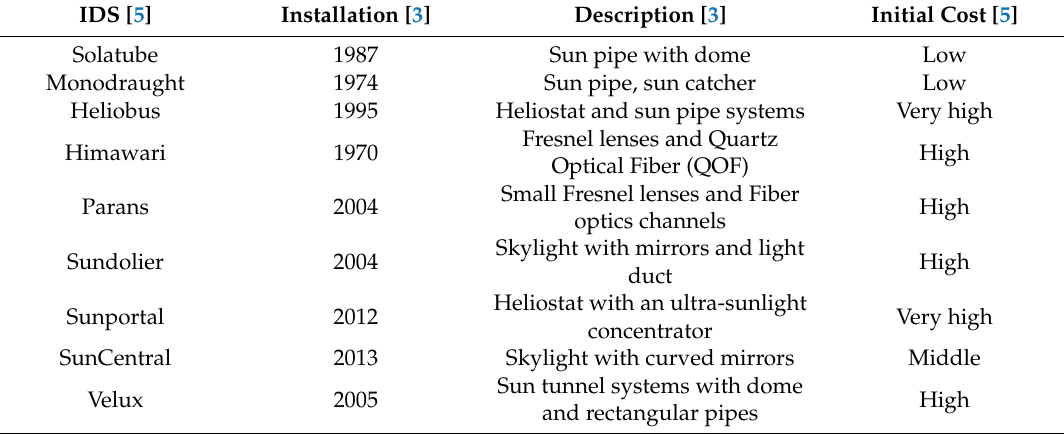
Table 2. Commercial Innovative Daylighting System (IDS) progress and composition. IDS [5] Installation